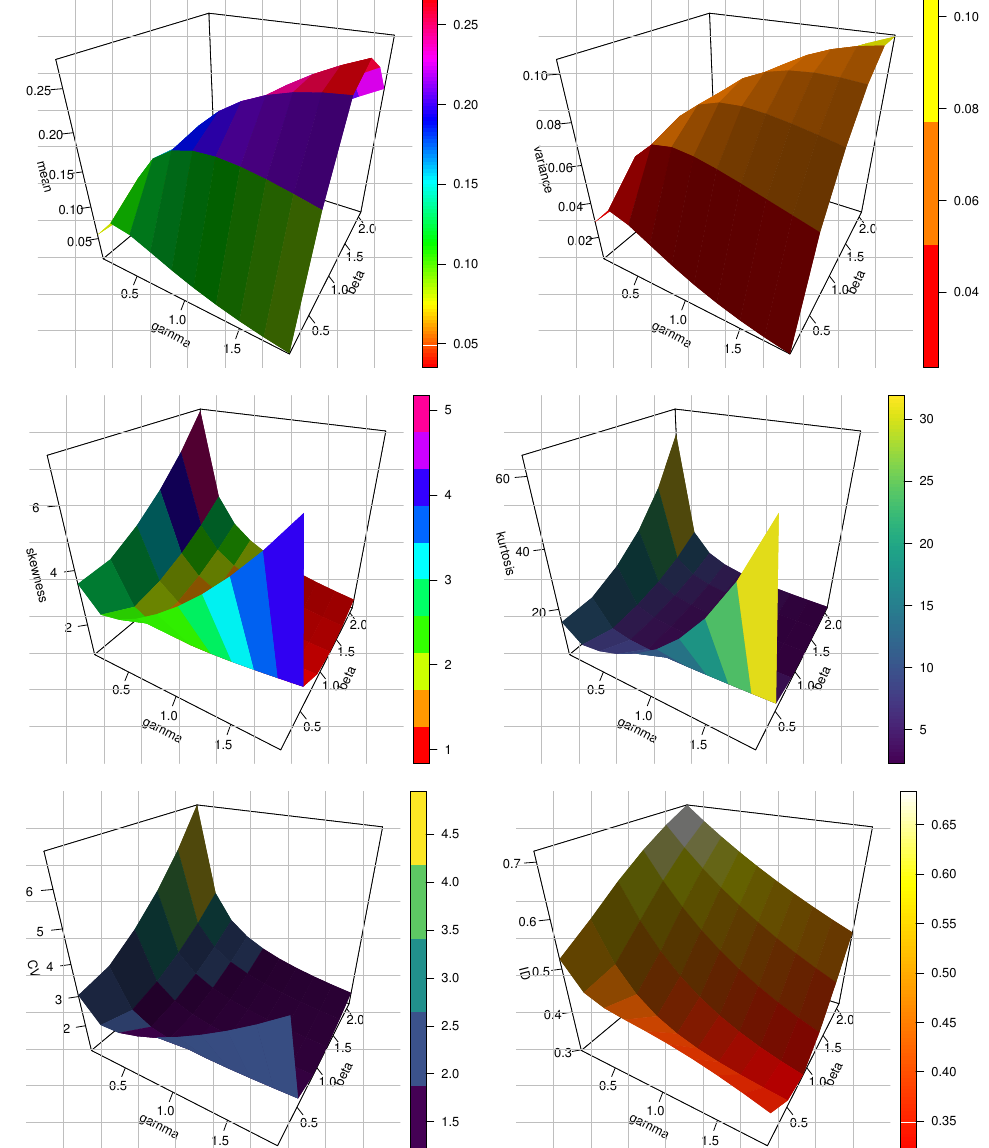
Figure 5. Plots of mean, var, SK, KU, CV and ID in 3D for the KMKE